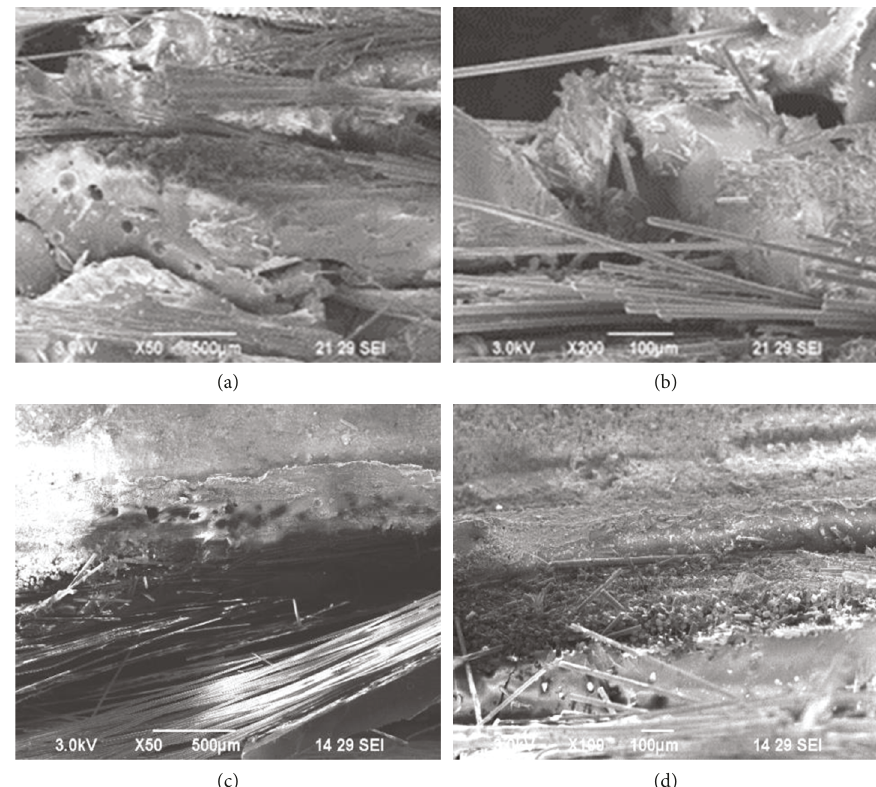
Figure 11: SEM images of fractures and surfaces of the FLM layer composite of (a) basalt fibre, (b) basalt-aluminium fibre, (c) glass fibre, and (d) aramid